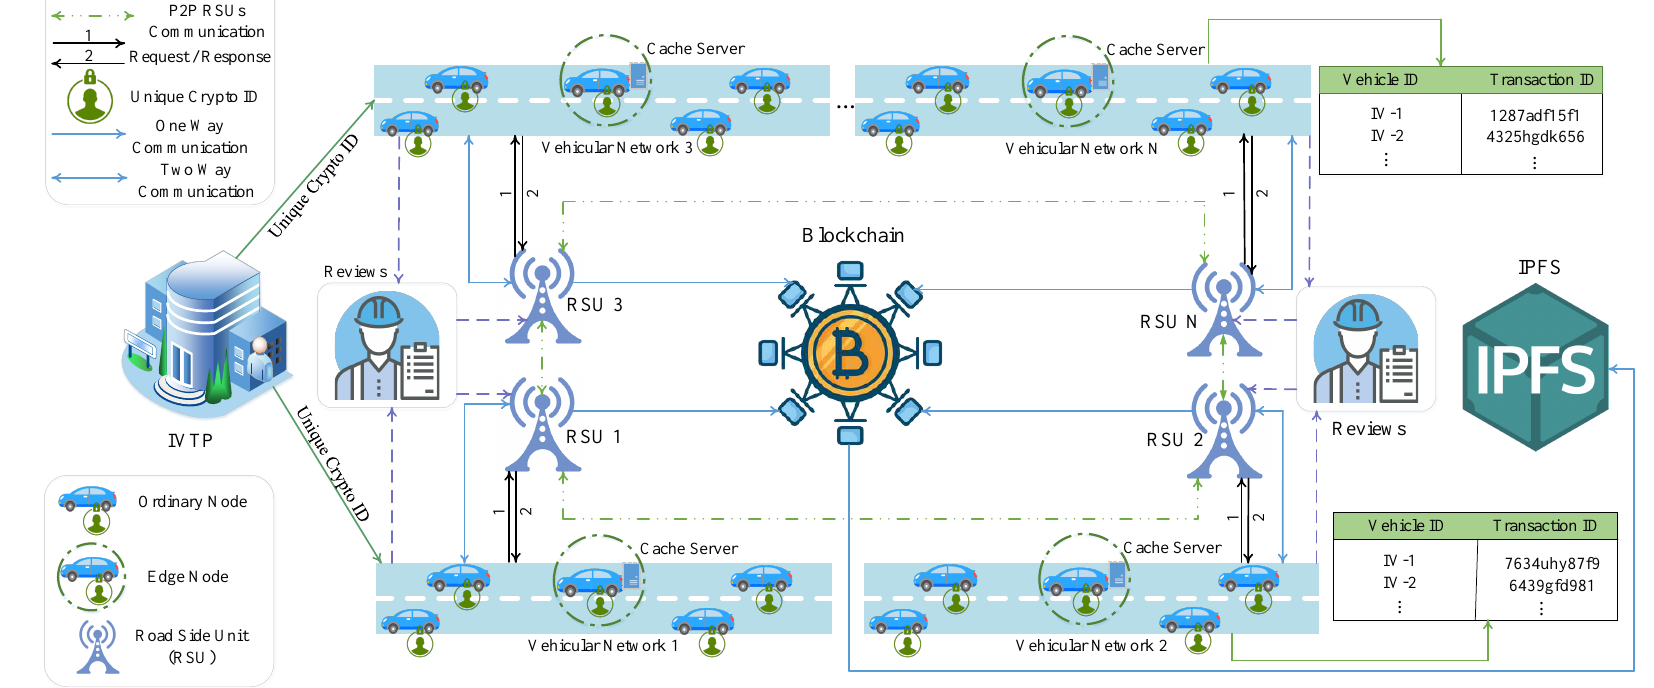
Figure 2. Proposed System